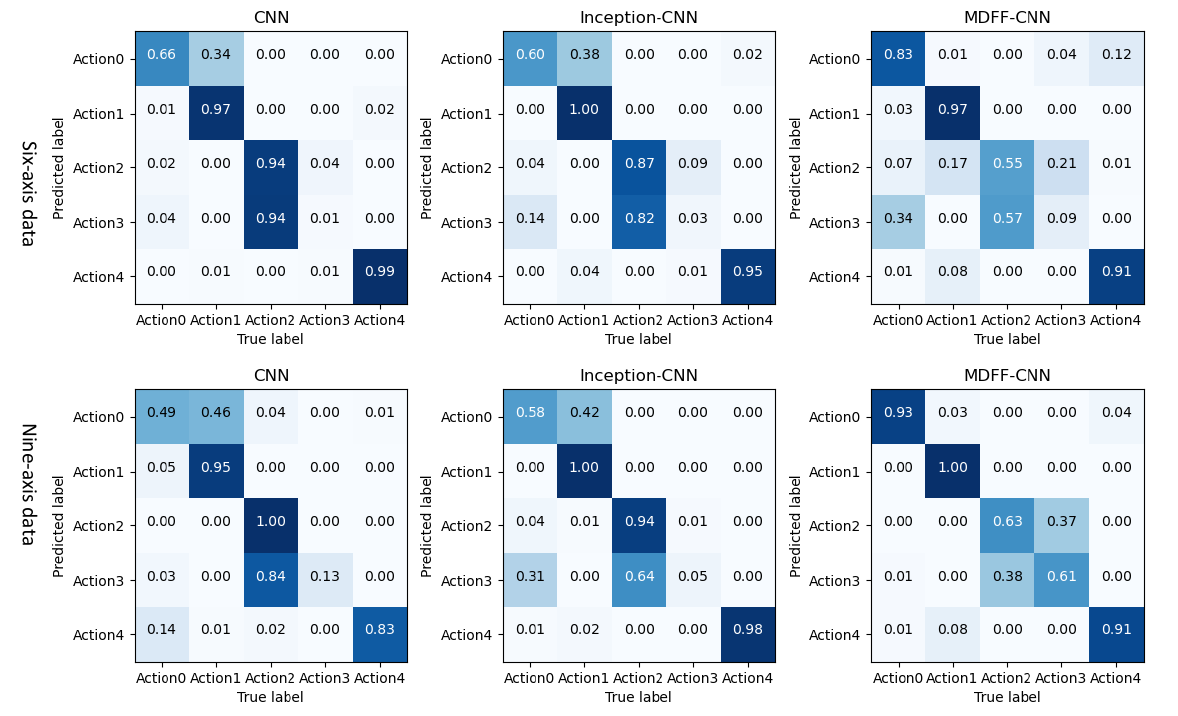
Figure 17. Recognition accuracy rate of convolutional neural network model on non-professional test set.